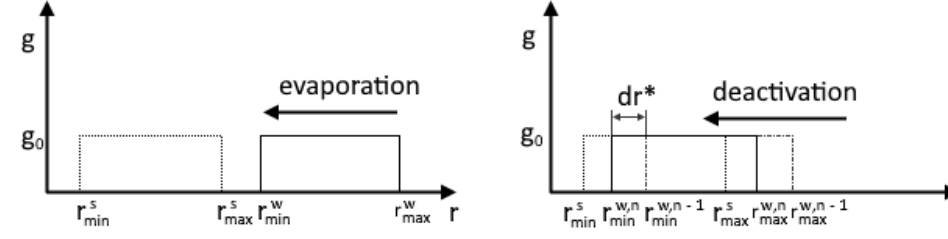
Figure 3. Comparison of evaporation and deactivation processes.